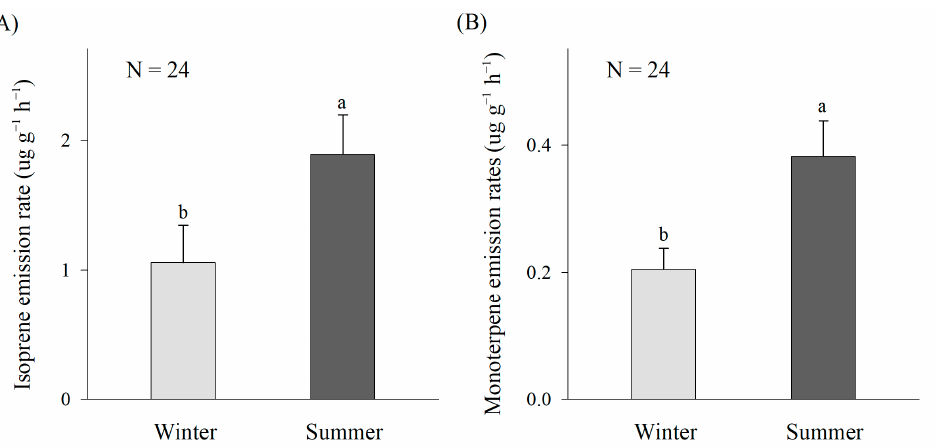
Figure 1. Seasonal patterns of the isoprene ( A ) and monoterpene ( B ) emission rates. The data are